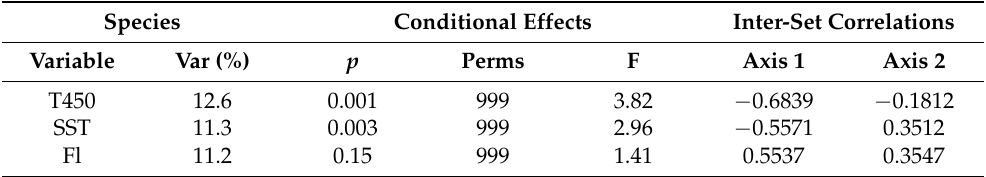
Table 6. Canonical correspondence analysis for the studied mesopelagic species and the environmen- tal variables SST (sea surface temperature), T450 (temperature at a 450 m depth), and FI (integrated fluorescence). Var (%) is the proportion of variance explained for each variable. P is the significance for each variable. Perms is the number of permutations and inter-set correlations of environmental variables with the first two axes. Species Conditional Effects Inter-Set Correlations